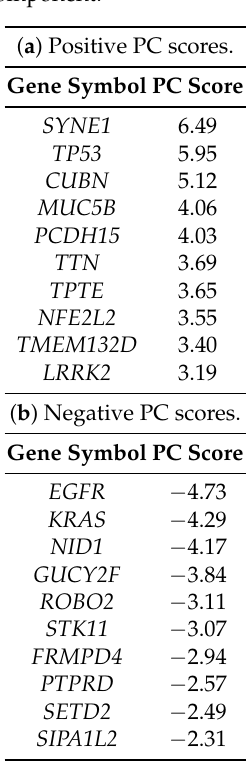
Table 5. Ten most frequent somatic mutations having ( a ) positive or ( b ) negative principal component (PC) scores for the second principal component.